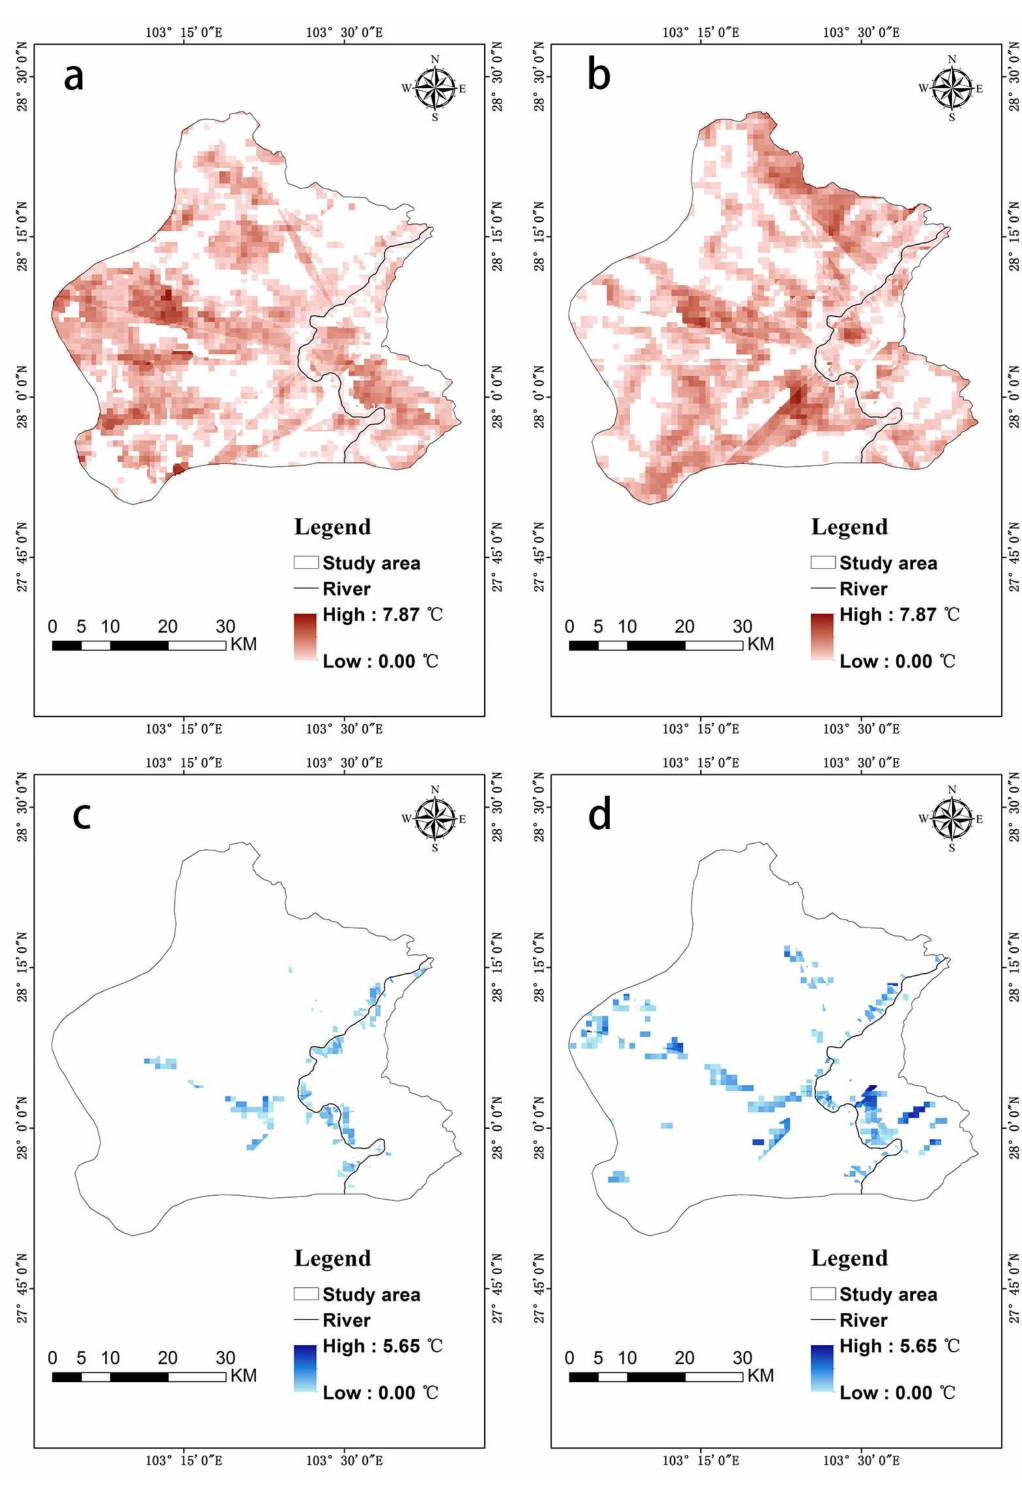
Figure 3. ( a ) Spatial distribution of warming effect in wet season; ( b ) spatial distribution of warming effect in dry season; ( c ) spatial distribution of cooling effect in wet season; and ( d ) spatial distribution of cooling effect in dry